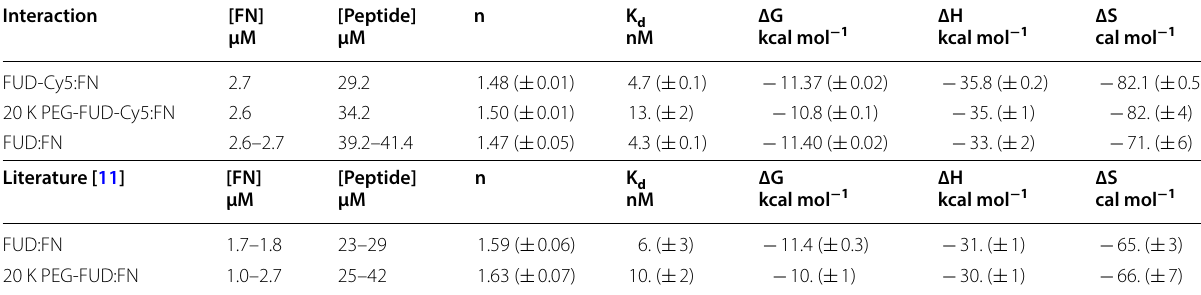
Table 1 Extracted isothermal titration calorimetry (ITC) experiment binding parameters Interaction [FN]